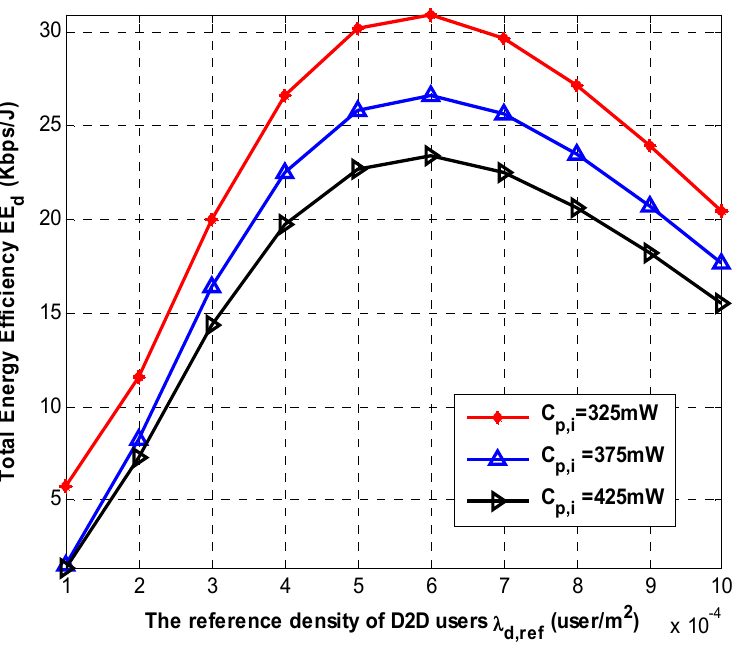
Figure 5. The energy efficiency of D2D users versus the reference density of D2D users by using the modified derivative algorithm.